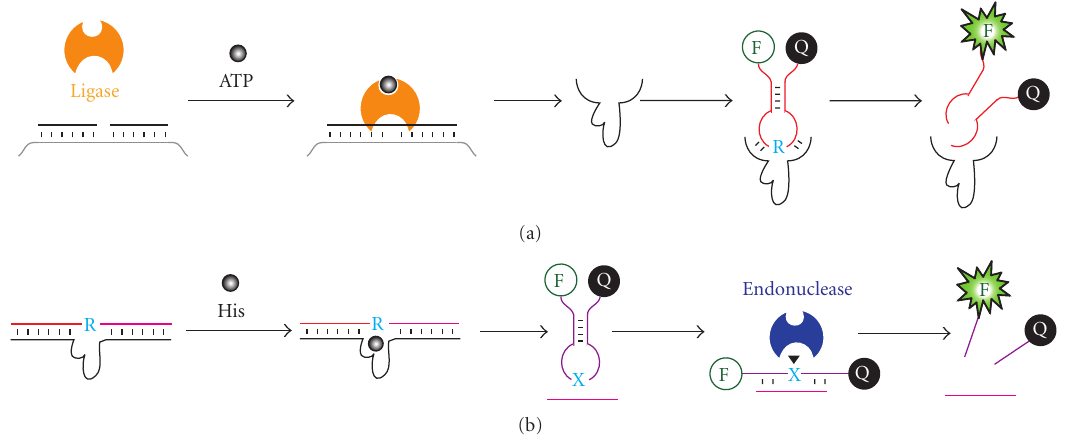
Figure 7: RNase DNAzyme for signal amplification. (a) Ligase/DNAzyme/MB sensor for ATP detection. ATP activates T4 DNA ligase to assemble a whole DNAzyme from two shorter DNA molecules; the DNAzyme cleaves a ribonucleotide (blue “R”) containing molecular beacon (MB) to generate a fluorescence signal. (b) DNAzyme/MB/endonuclease sensors for histidine. Histidine (His) activates the DNAzyme; the cleavage of the substrate by the DNAzyme produces a small DNA fragment (shown as the pink line) that bind an MB to assemble the recognition site (blue “X”) for a nicking endonuclease, which cleaves the MB to generate a fluorescence